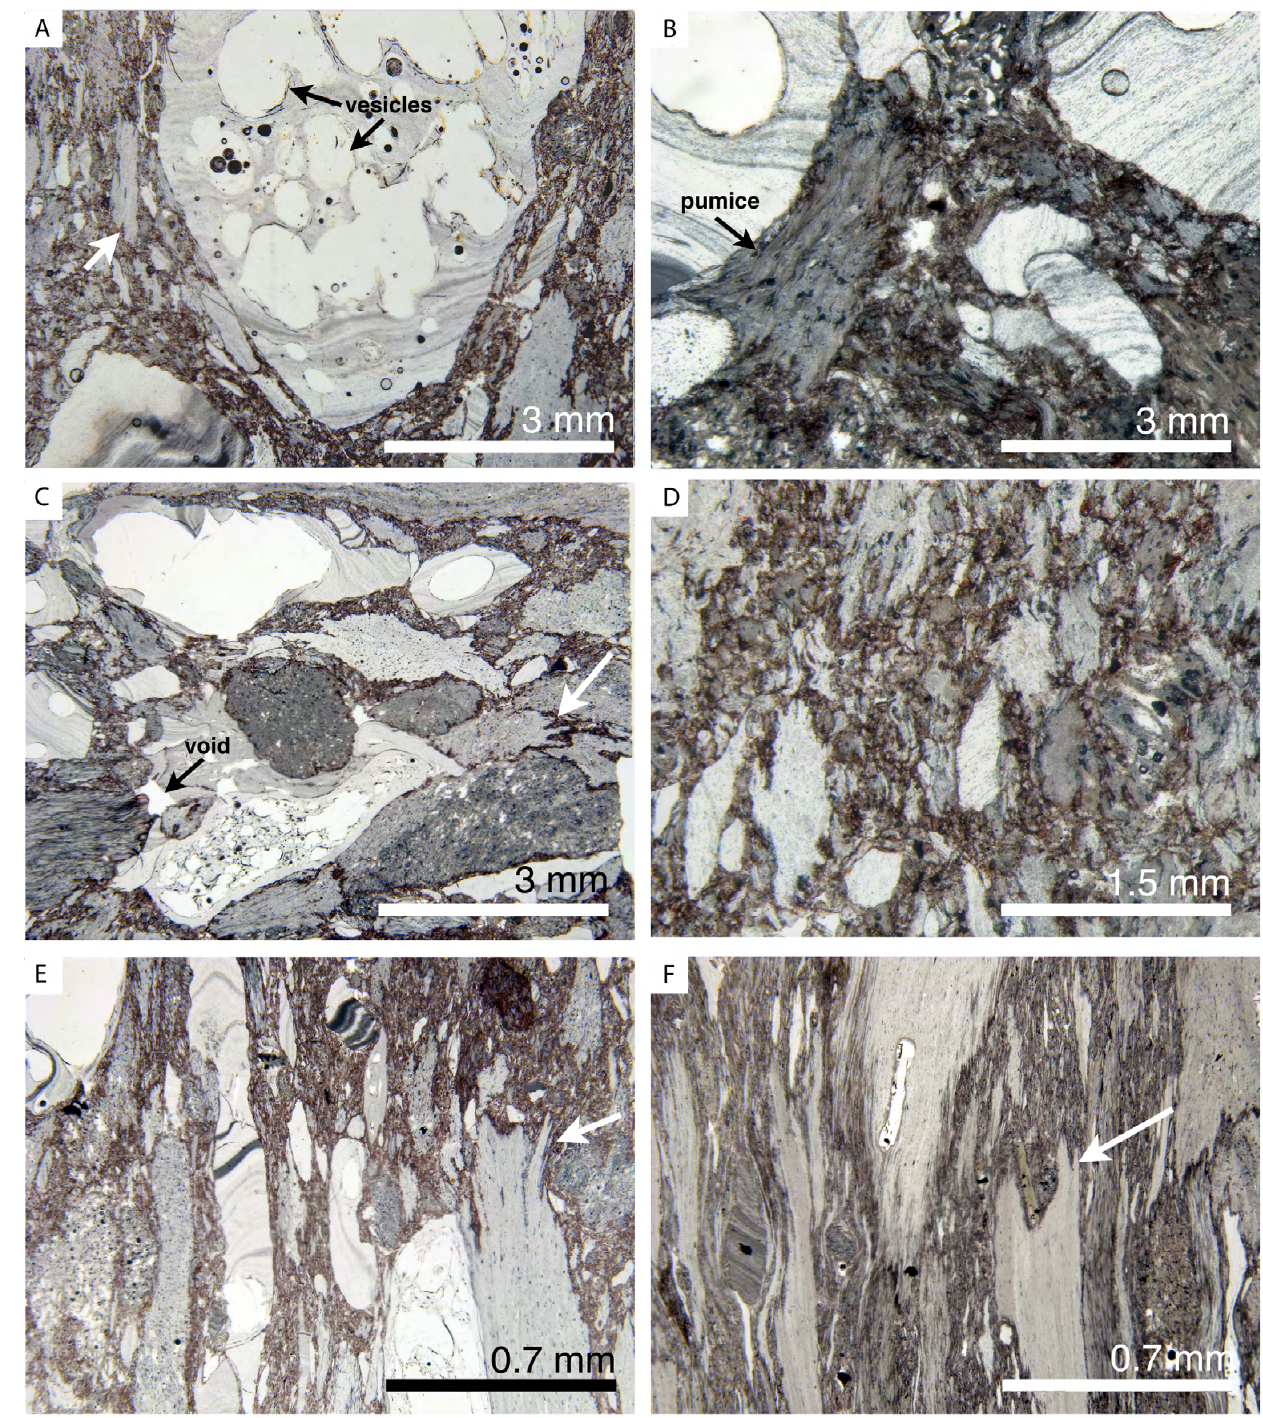
Figure 4: Optical light photomicrographs of breccia material sampled from the BGM lava flow. In thin section, the breccia comprises variable amounts of fine ash matrix and lapilli-sized clasts. The fragments themselves consist of dense, often flow banded glass, to moderately vesicular pumice [A], [B]. Frames [A] and [B] show relatively outsized flow banded obsidian clasts that underwent secondary vesiculation that disrupts flow banding. Such evidence, along with prevalent fiamme structures (white arrows in frames [A], [C], [E], and [F]) indicates that post- fragmentation welding and expansion occurred while material was pyroclasts were still hot, relatively hydrous, and above the glass transition point [~740 °C: Castro et al. 2005a]. Frame [C] shows the abundance of diverse clasts with sutured grain boundaries and some remnant pore space (void). Frames [D] through [F] indicate the progression of increasing welding intensity in dense sintered ash, from moderate [D] to extreme